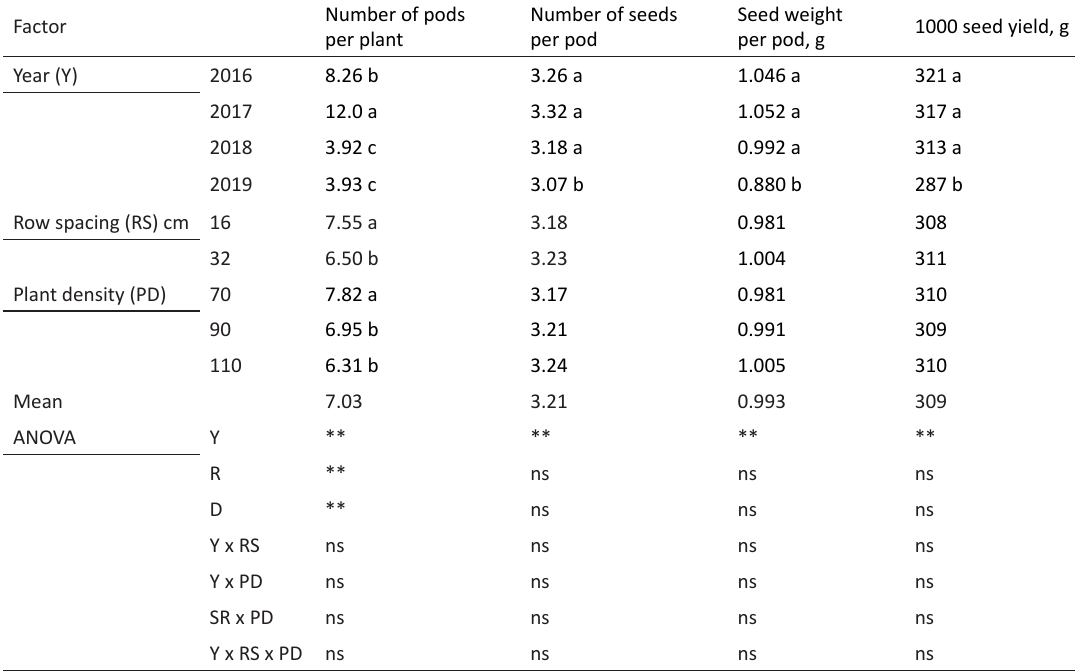
Table 6. White lupin yield components depending of row spacing and plant density in 2016–2019 Factor